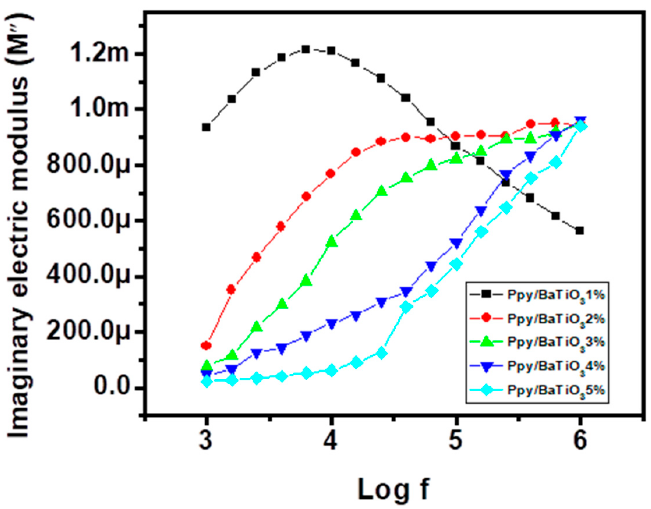
Figure 14. Variation of imaginary part of electric modulus with frequency for PPy/BaTiO 3 composites.